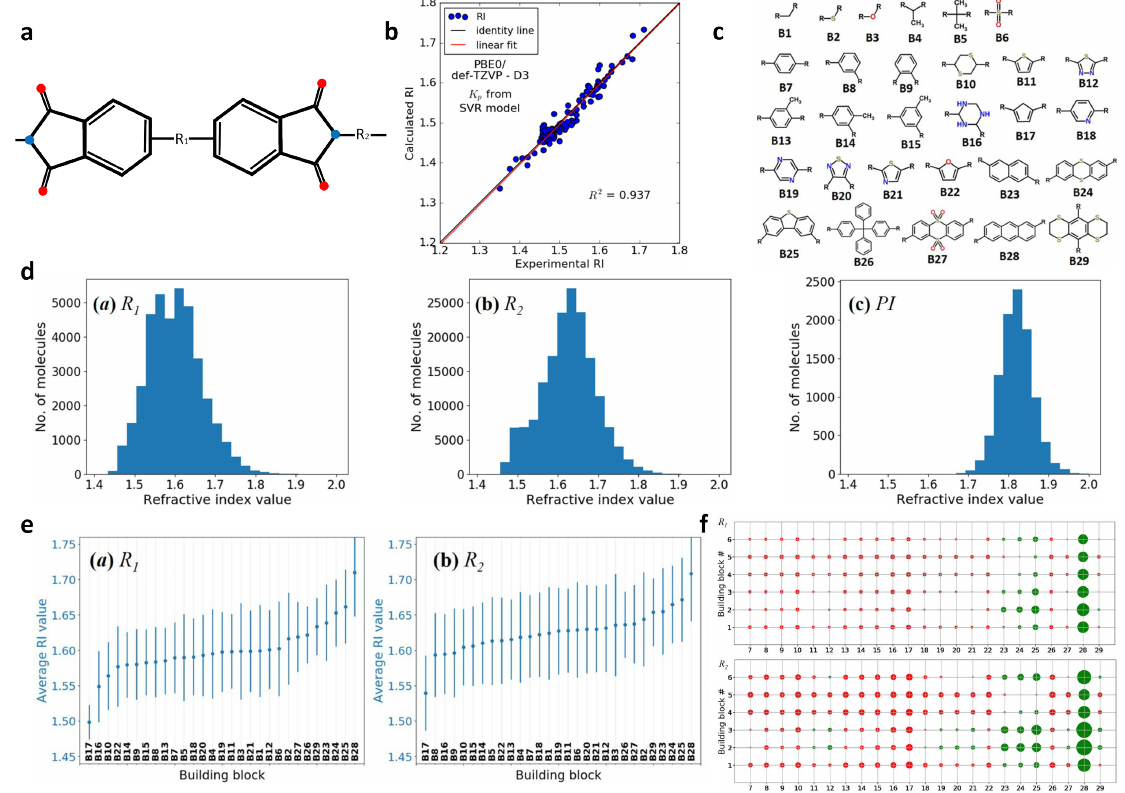
Figure 6. Accelerated design of polyimides (PIs) with high refractive index. ( a ) The core structure of PI with R1 and R2 group (blue and red nodes denote nitrogen and oxygen atoms, respectively); ( b ) the performance of the support vector regression (SVR) model (adapted from Reference [102] with permission, copyright 2018 AIP publishing); ( c ) 29 building blocks; ( d ) the distribution of molecules versus the RI values for R1, R2, and PIs; ( e ) RI values in terms of each building block for R1 and R2; ( f ) Z-score of building pairs for R1 and R2 ( c – f ) are adapted from Reference [100] with permission, copyright 2019 American Chemical